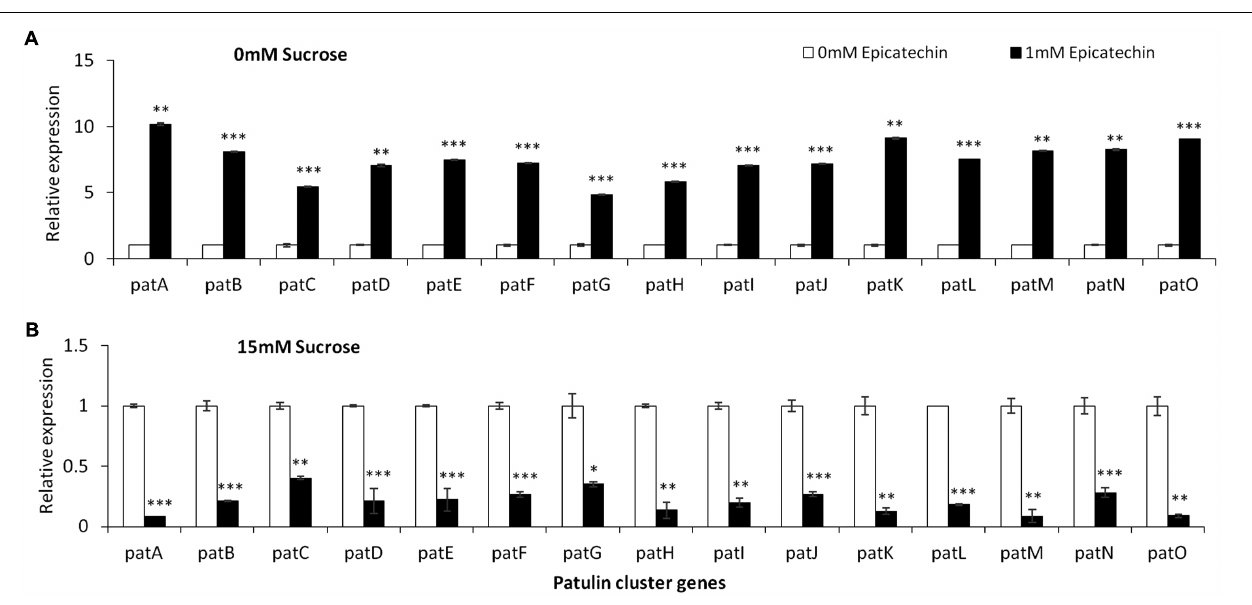
FIGURE 9 | pat genes cluster (PGC) relative expression as affected by epicatechin and different levels of sucrose. Solid SM media at initial pH 5.0 amended with 0 (A) , and 15 (B) sucrose was combined with increasing concentrations of chlorogenic acid from 0 and up to 1 mM. The media was inoculated with 100 µ l of a 10 6 spore/ml suspension and the relative expression patA, patB, patC, patD, patE, patF, patG, patH, patI, patJ, patK, patL, patM, patN, patO between both treatments were compared. Expression was evaluated 3 days post-inoculation after the mycelia was sampled from the culture plates. Average values ( ± SE) of five replicates are reported. Experiments were repeated three times and results of a single representative experiment are